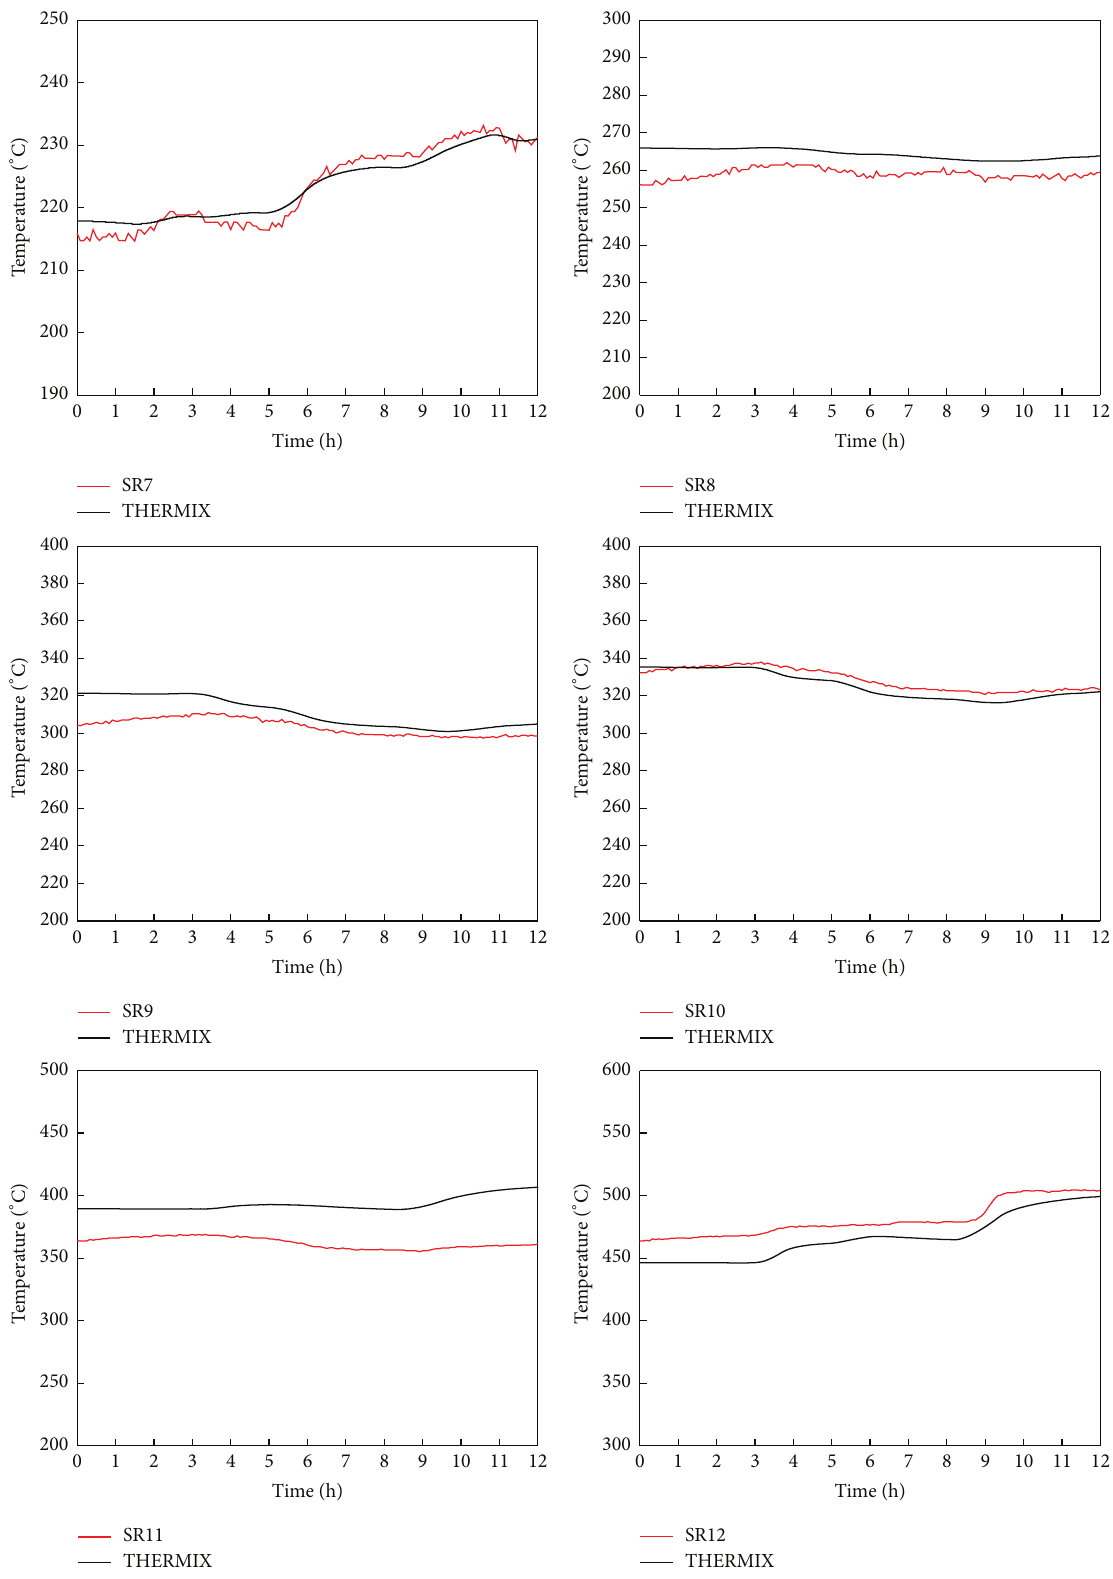
Figure 13: Temperature transient of the side internals (lower